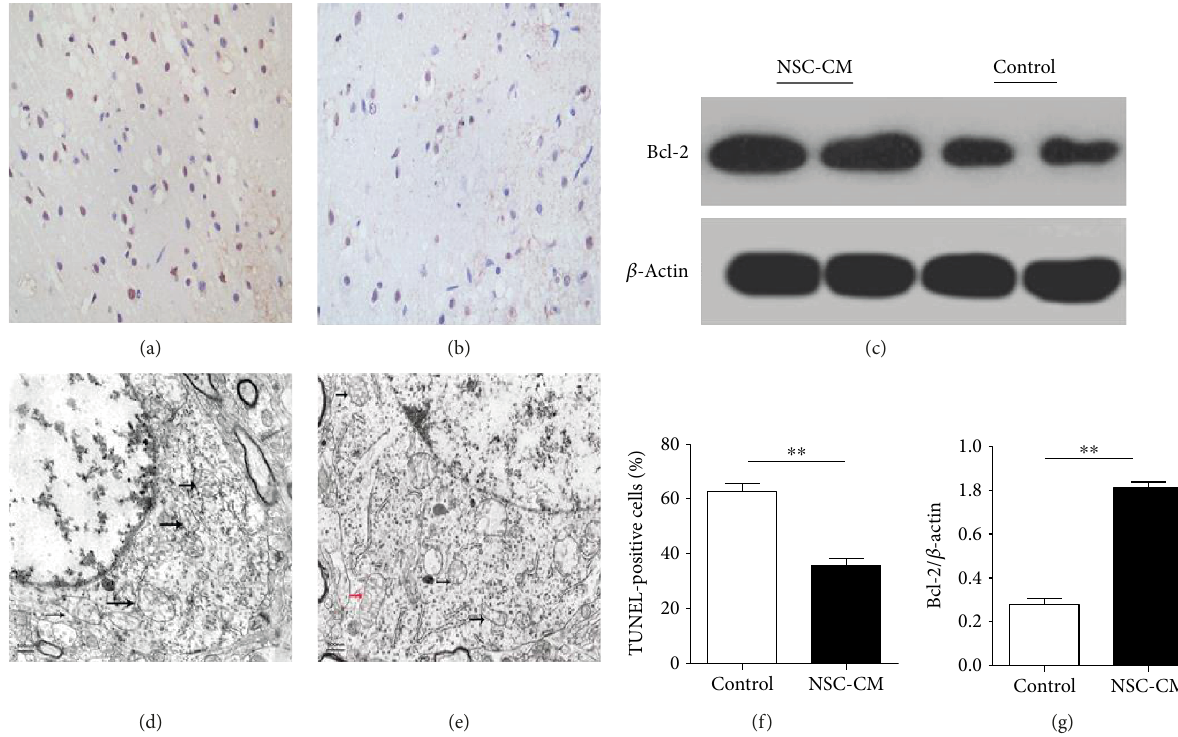
Figure 2: The e ff ect of NSC-CM on cell apoptosis and mitochondrial ultrastructure in the ischemic sphere. Representative TUNEL staining image on the 3rd day after cerebral ischemia onset of the control group (a) and the NSC-CM group (b). The brown particle is the TUNEL- positive cells whereas the blue particle is the normal cells (c). The protein expression of Bcl-2 in the cerebral ischemia penumbra of 2 groups assessed by Western blot. Control: the group receiving PBS by tail vein injection; NSC-CM: the group receiving NSC-CM by tail vein injection. Representative mitochondrial ultrastructures of the control group (d) and the NSC-CM group (e) in neuron. The black arrows indicated swollen mitochondria with disintegrated or disappeared cristase. The red arrows indicated normal mitochondria with integrated cristase. Bar: 500 nm (f). The bar graph showing that NSC-CM signi fi cantly decreased the number of TUNEL-positive cells in cerebral ischemic hemisphere, compared to the control group. ∗∗ P < 0 01 , two-sample t test (g). The bar graph showing that NSC-CM signi fi cantly increased the expression of Bcl-2 in cerebral ischemic hemisphere, compared to control group. ∗∗ P < 0 01 , Two-sample t